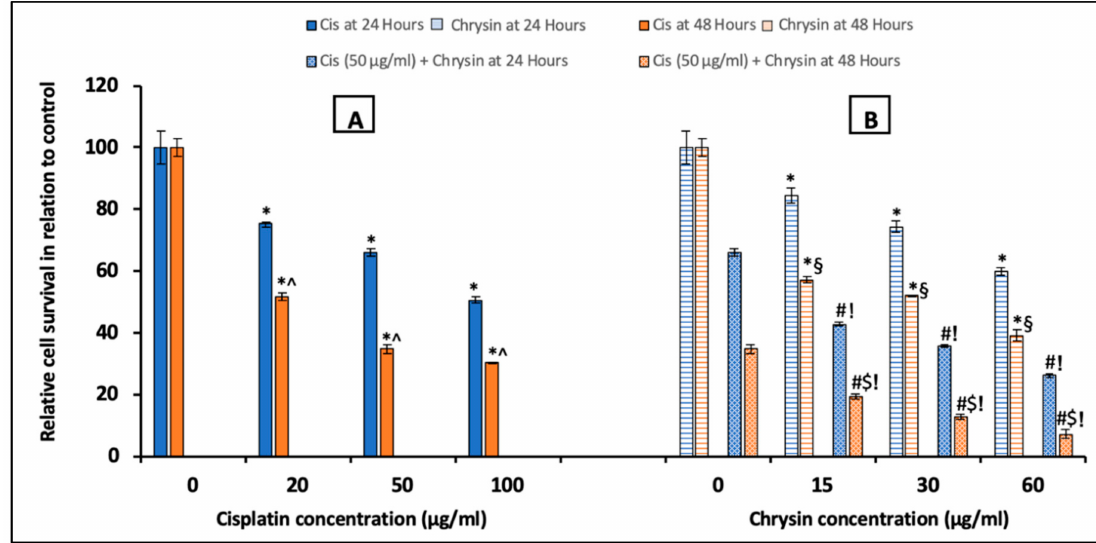
Figure 1. Impact of 24 and 48 h treatment with ( A ) cisplatin (Cis; 20, 50, 100 µ g / mL), ( B ) chrysin (15, 30, 60 µ g / mL) and combination of chrysin (15, 30, 60 µ g / mL) with Cis 50 µ g / mL on cell survival in HepG2 cells. Results are presented as Mean ± SD. * p < 0.05 versus the control untreated cells. ˆ p < 0.05 versus the same dose of Cis treatment for 24 h. # p < 0.05 versus the same dose of chrysin at the same incubation time. ! p < 0.05 versus Cis 50 µ g / mL at the same incubation time. § p < 0.05 versus the same dose of chrysin treatment for 24 h. $ p < 0.05 versus cis 50 µ g / mL + the same dose of chrysin treatment for 24